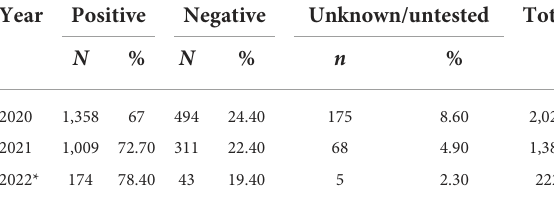
TABLE 3A Death related to COVID-19 (hypertension/diabetes).